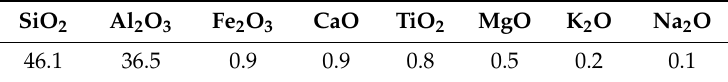
Table 1. Composition (wt %) of the kaolin clay used.